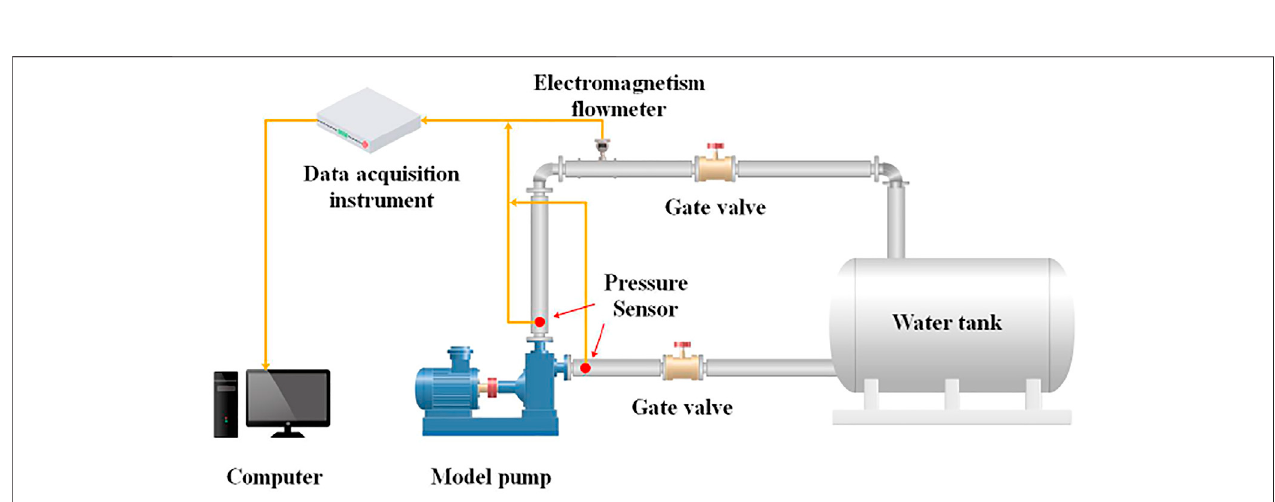
FIGURE 4 | Diagrams of mesh independence veri fi cation. (A) Diagram of fl ow fi eld mesh independence. (B) Diagram of rotor domain mesh.